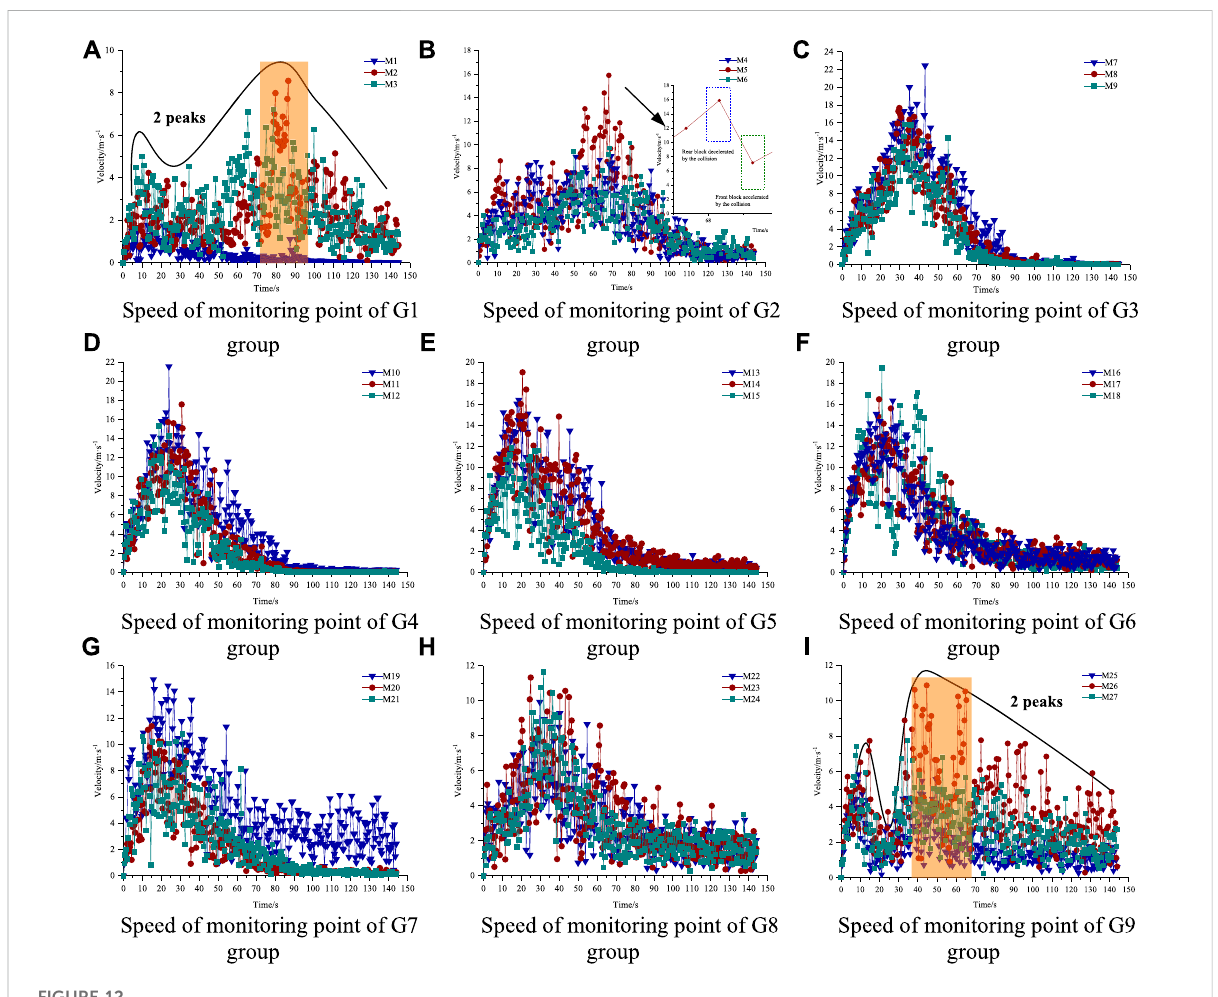
FIGURE 12 Speed of sliding mass monitoring unit. (A) Speed of monitoring point of G1, (B) Speed of monitoring point of G2, (C) Speed of monitoring point ofG3, (D) SpeedofmonitoringpointofG4, (E) SpeedofmonitoringpointofG5, (F) SpeedofmonitoringpointofG6, (G) Speedofmonitoringpointof G7, (H) Speed of monitoring point of G8, (I) Speed of monitoring point of